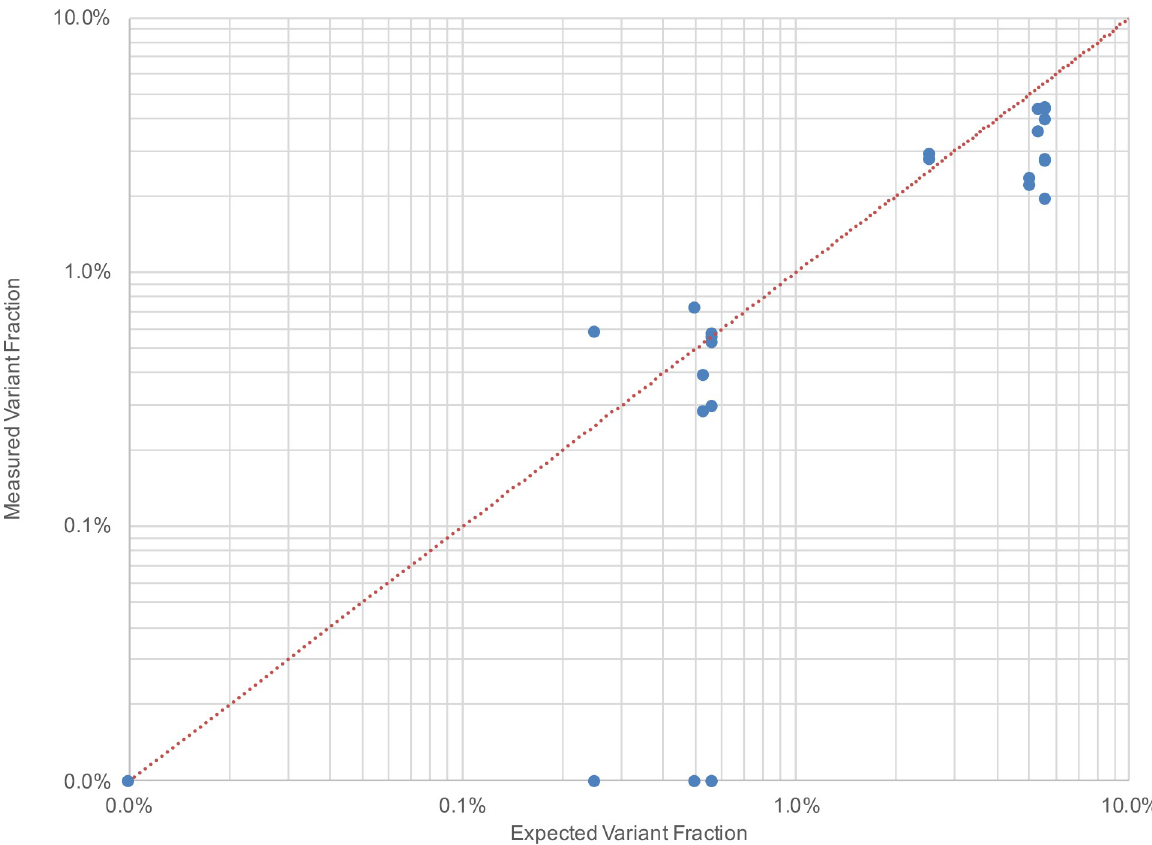
Fig 3. Expected vs. measured SNV, indel and fusion fractions. The dotted line represents a 1:1 ratio of expected vs. measured variants. Undetected and zero variant fraction samples were reported at 0.0% for display